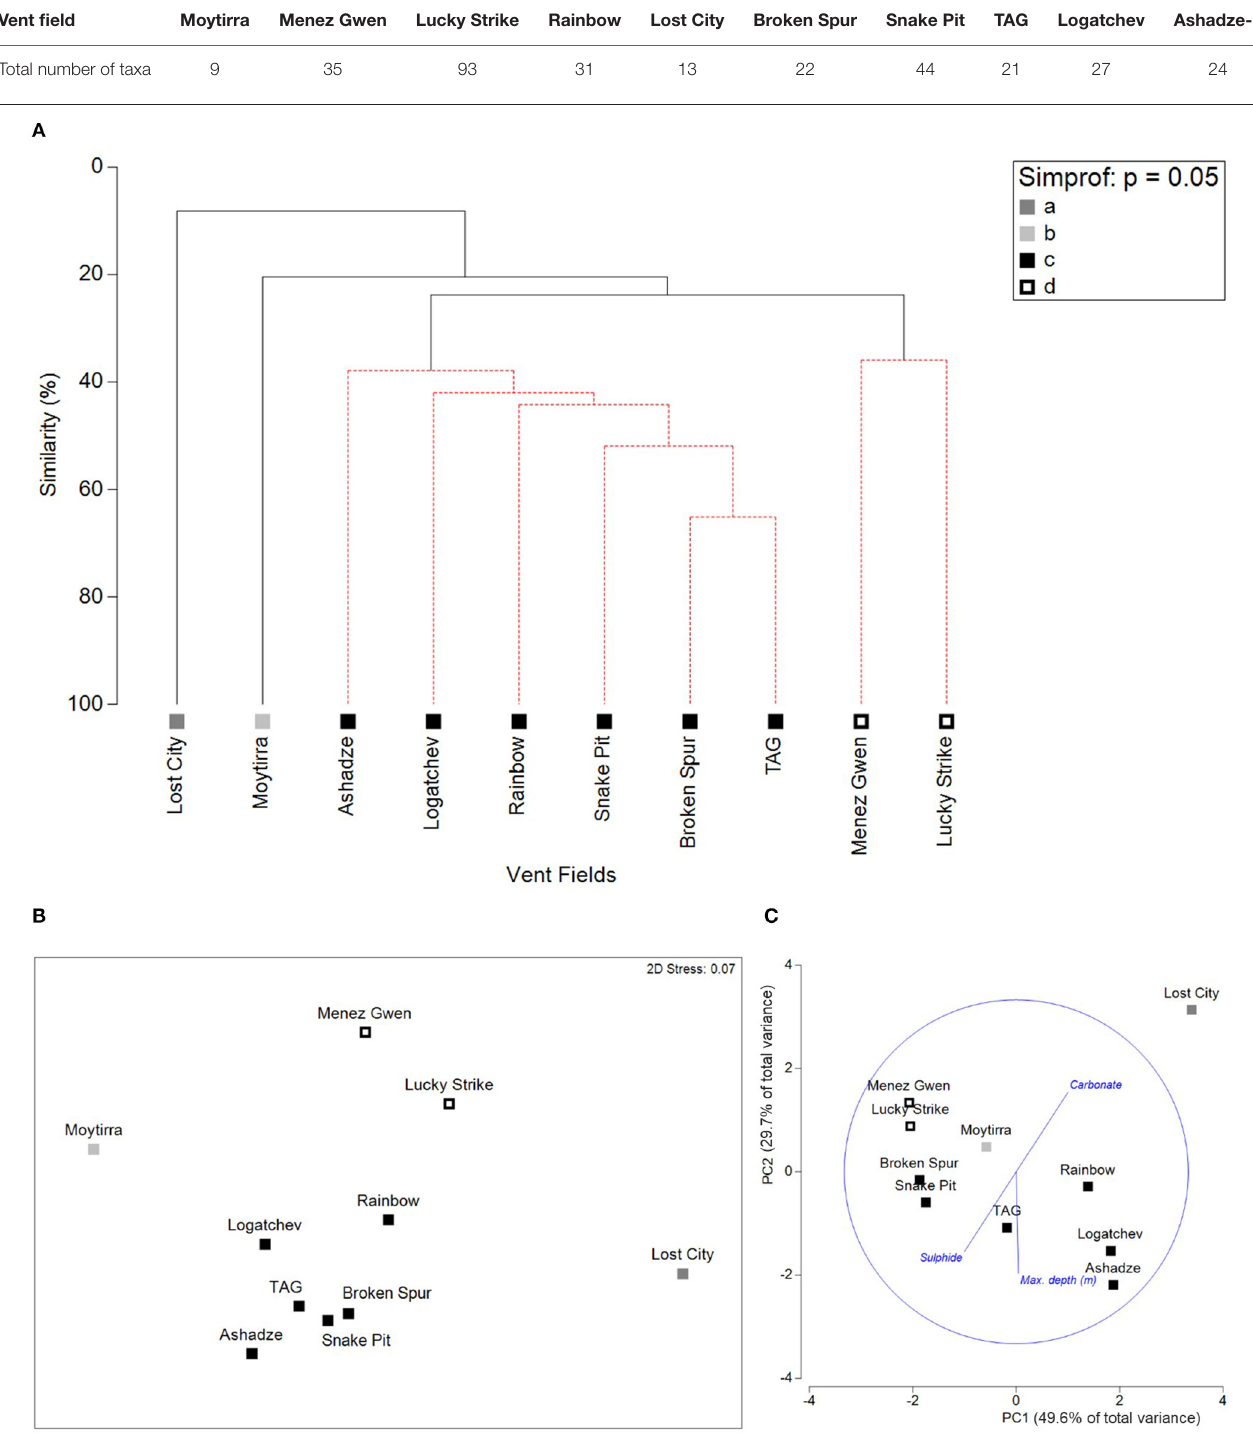
TABLE 2 | Number of taxa recorded from each of the 10 vent fields included in the study, from North to South: Moytirra, Menez Gwen, Lucky Strike, Rainbow, Lost City, Broken Spur, TAG, Snake Pit, Logatchev, and Ashadze 1.